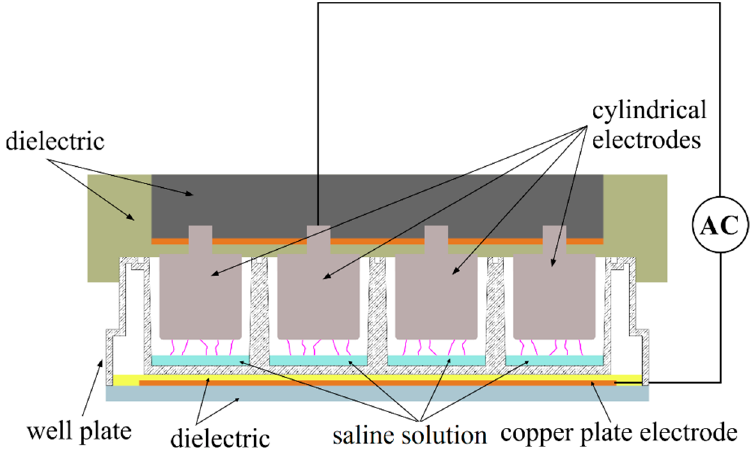
Figure 1. The air DBD plasma experimental setup for saline solution activation.